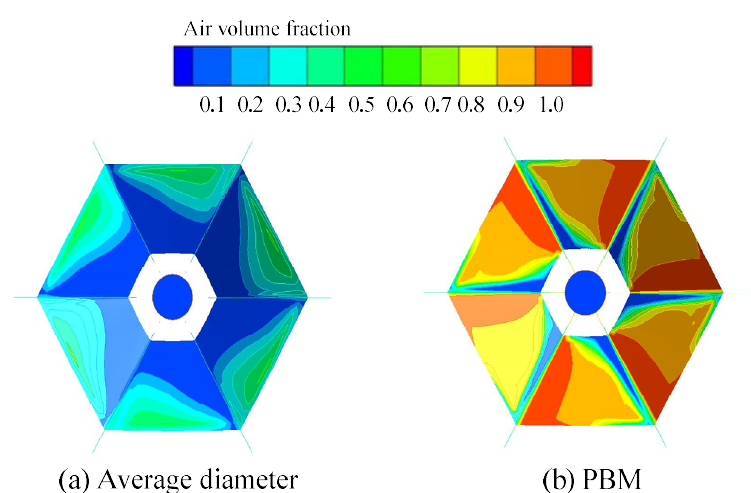
Figure 10. Distribution of air volume fraction. ( a ) Average diameter, ( b ) PBM.